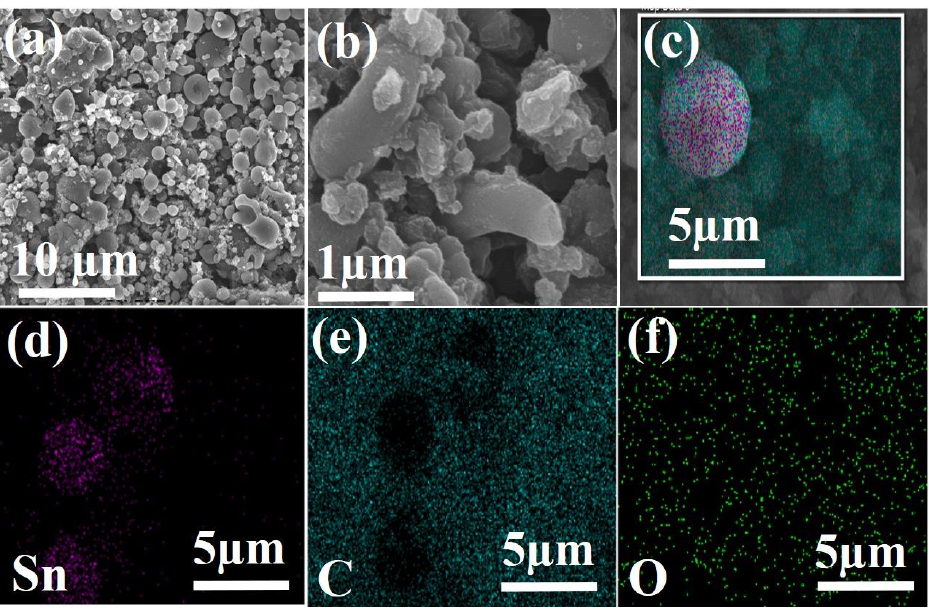
Figure 2. ( a , b ) SEM images; and ( c – f ) EDS and the corresponding elemental mapping Sn, C and O of as-prepared Sn/SnO 2 /C nano-composite.